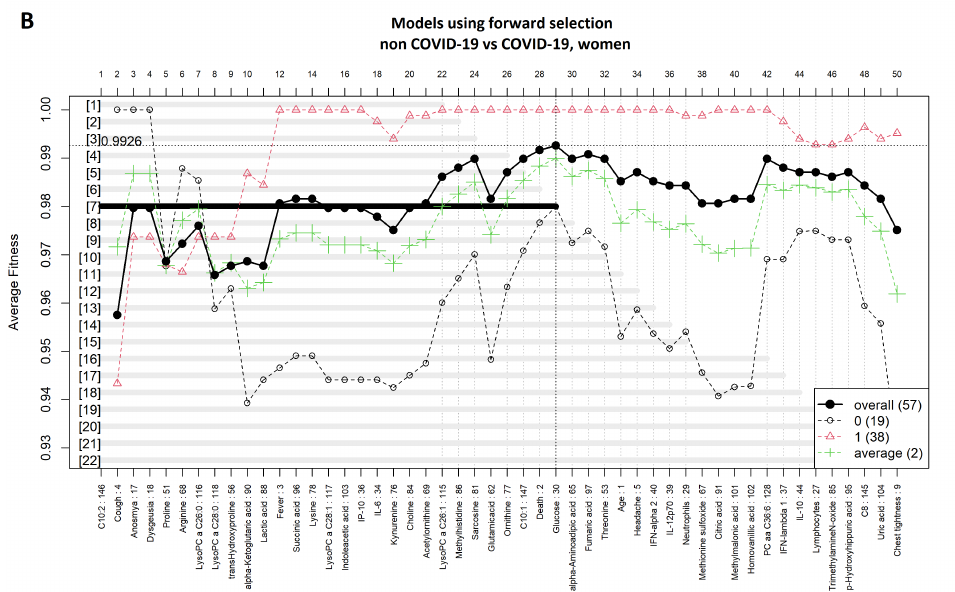
Figure 6. Forward selection model construction for classification of women with and without COVID-19. ( A ) logistic regression and ( B ) support vector machine models. The vertical axis shows the classification accuracy. The solid line represents the overall accuracy calculated by measuring the misclassified samples divided by the total number of samples. The colored dashed lines represent the accuracy per class [36]. The logistic regression function was computed using an external imple- mentation coupled to the GALGO library; therefore, the dashed/average lines for this model could not be computed.